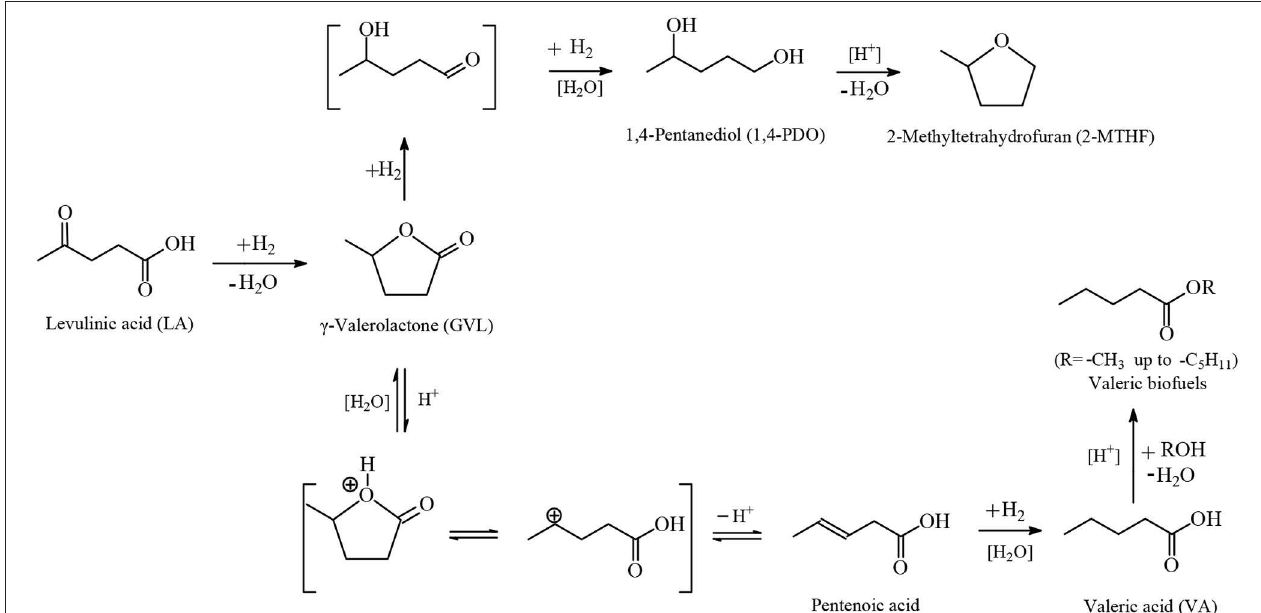
FIGURE 9 | Hydrogenation of LA beyond GVL to yield VA for the production of valeric biofuels and 1,4-PDO followed by dehydration to form 2-MTHF.